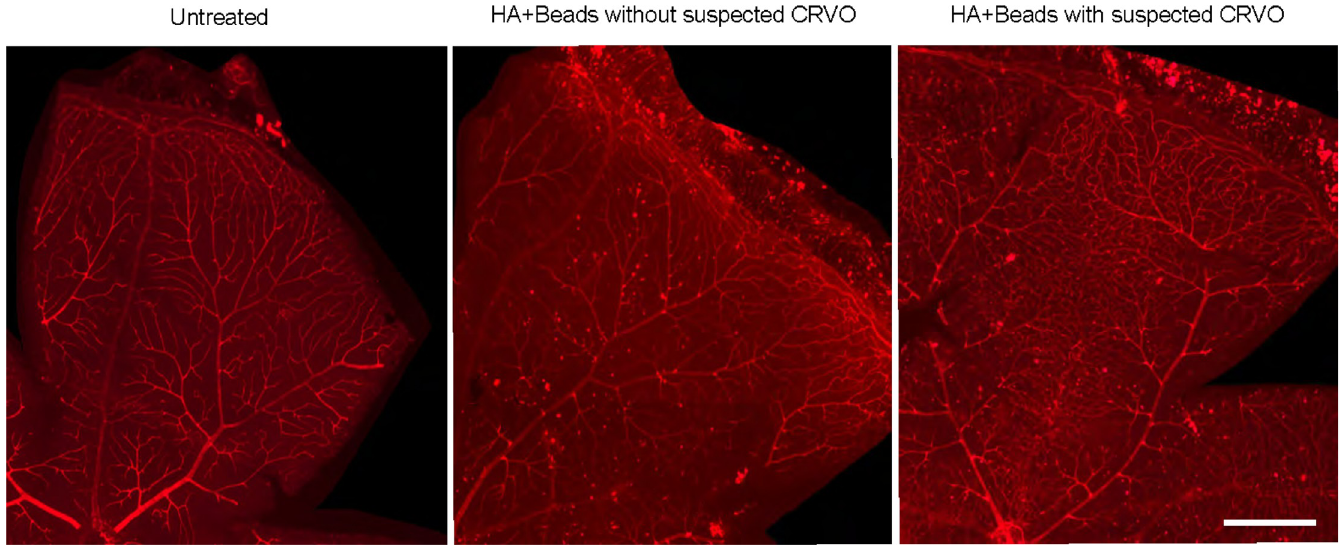
Fig 7. Lectin-stained retinas of the (A) normal, untreated group, (B) hyaluronic acid (HA)+Beads group without suspected CRVO, and (C) HA+Beads group with suspected CRVO. (B) Slightly dilated and tortuous vessels were observed in the distal area 30 days post-injection. (C) Tortuous vessels and small dilated vessels among large to middle-sized vessels were observed from the optic disc to the peripheral retina. Scale bar = 500 μ m.